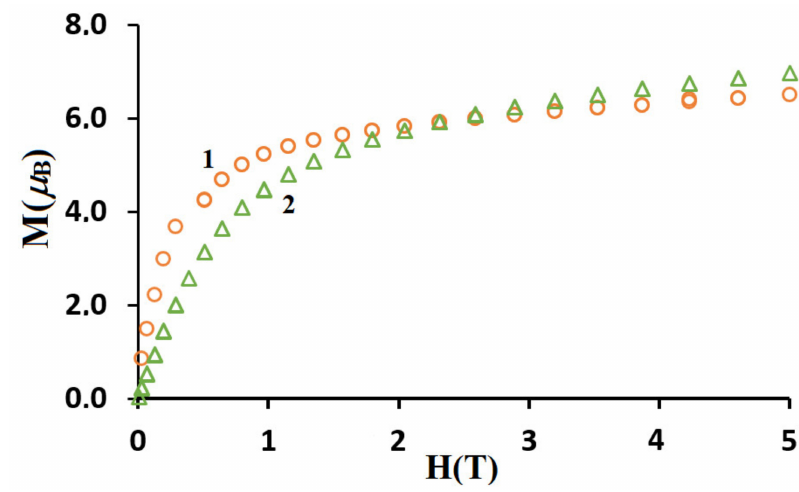
Figure 9. Field dependence of the magnetization for complexes 1 and 2 at 2